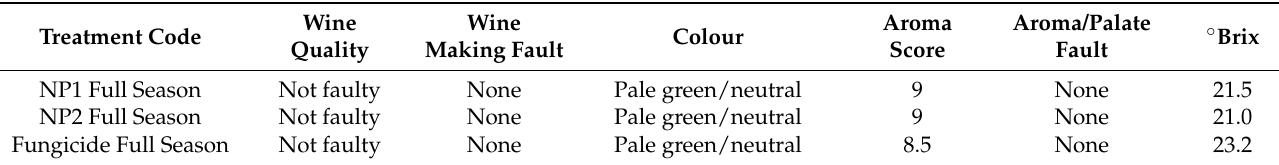
Table 1. Sensory analysis (by a trained sensory panel of five wine judges) of Chardonnay wines made from the Season 2 vintage from Hawke’s Bay. Treatment